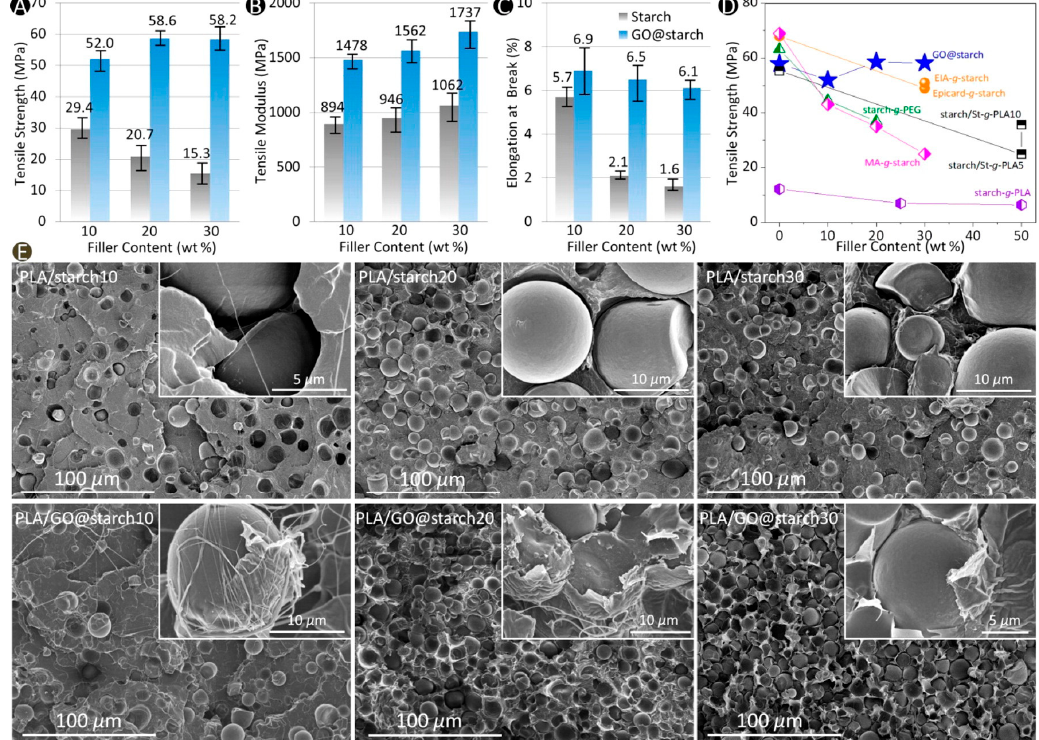
Figure 22. Mechanical properties of composite films. ( A ) Tensile strength; ( B ) tensile modulus; and ( C ) elongation at break demonstrating the superior tensile properties of PLA/GO@starch in comparison with PLA/starch; ( D ) Comparison of tensile strength for modified PLA/starch composites using